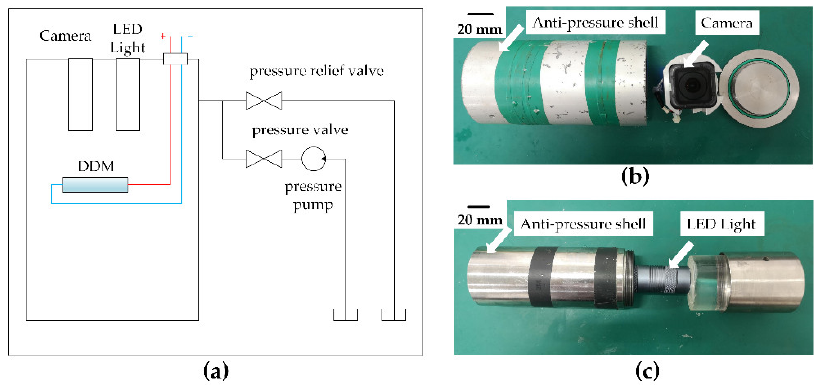
Figure 6. Anti-pressure characteristics test bench: ( a ) schematic of the anti-pressure characteristics testing system, ( b , c ) experimental processes recorded using a video camera ( b ), and LED light ( c ) protected by anti-pressure shells.